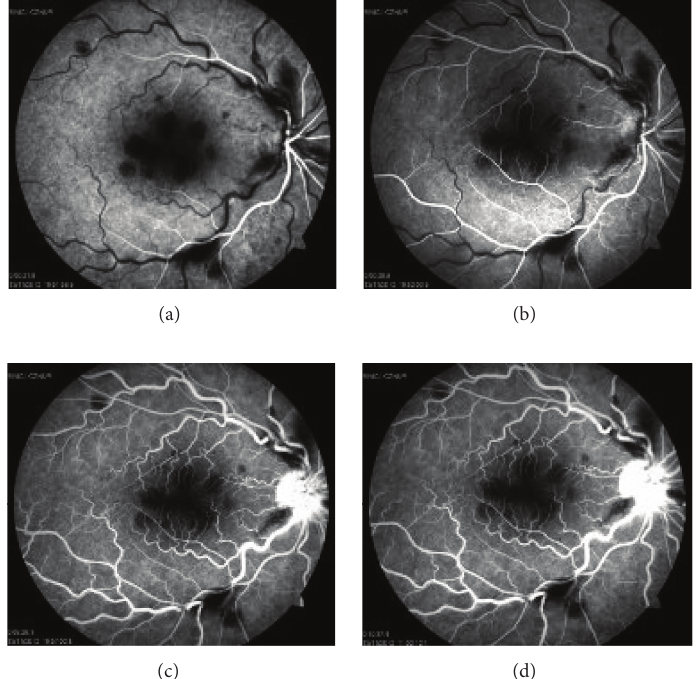
Figure 3: Fundus fluorescein angiography of the right eye at initial examination. (a and b) Early phase of FFA shows capillary filling defect. (c and d) Late phase of FFA shows leakage from the optic